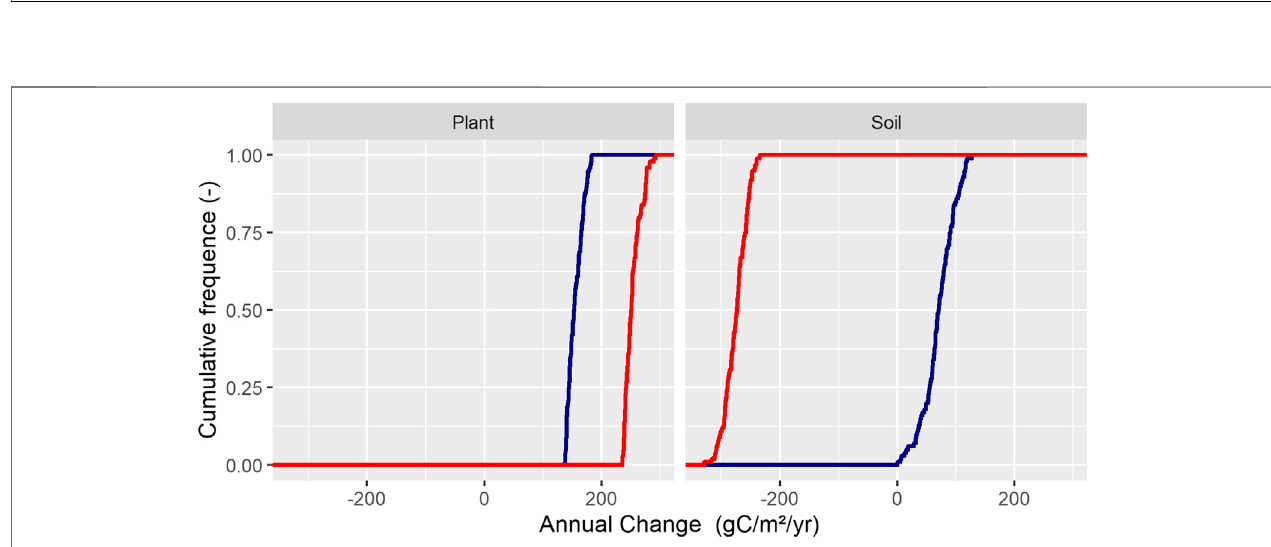
FIGURE 9 | Variation within the 100 accepted model runs is shown as the frequency distribution of annual carbon change in vegetation and soil, for K (blue) and L (red). A positive number here shows accumulation.